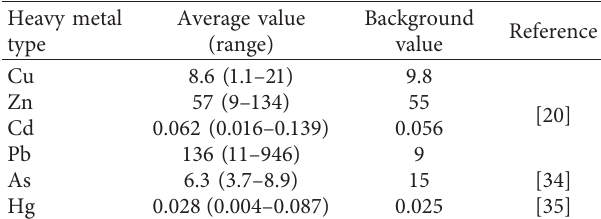
Table 7: Heavy metal contents and background values in sediments of Jiuzhen Bay ( µ g/g dw).